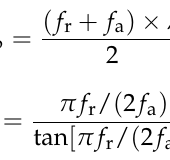
Table 1. Parameters adopted in the FEM studies. Items Details Items Details Number of electrodes 2 Shape of unit cell Thickness of